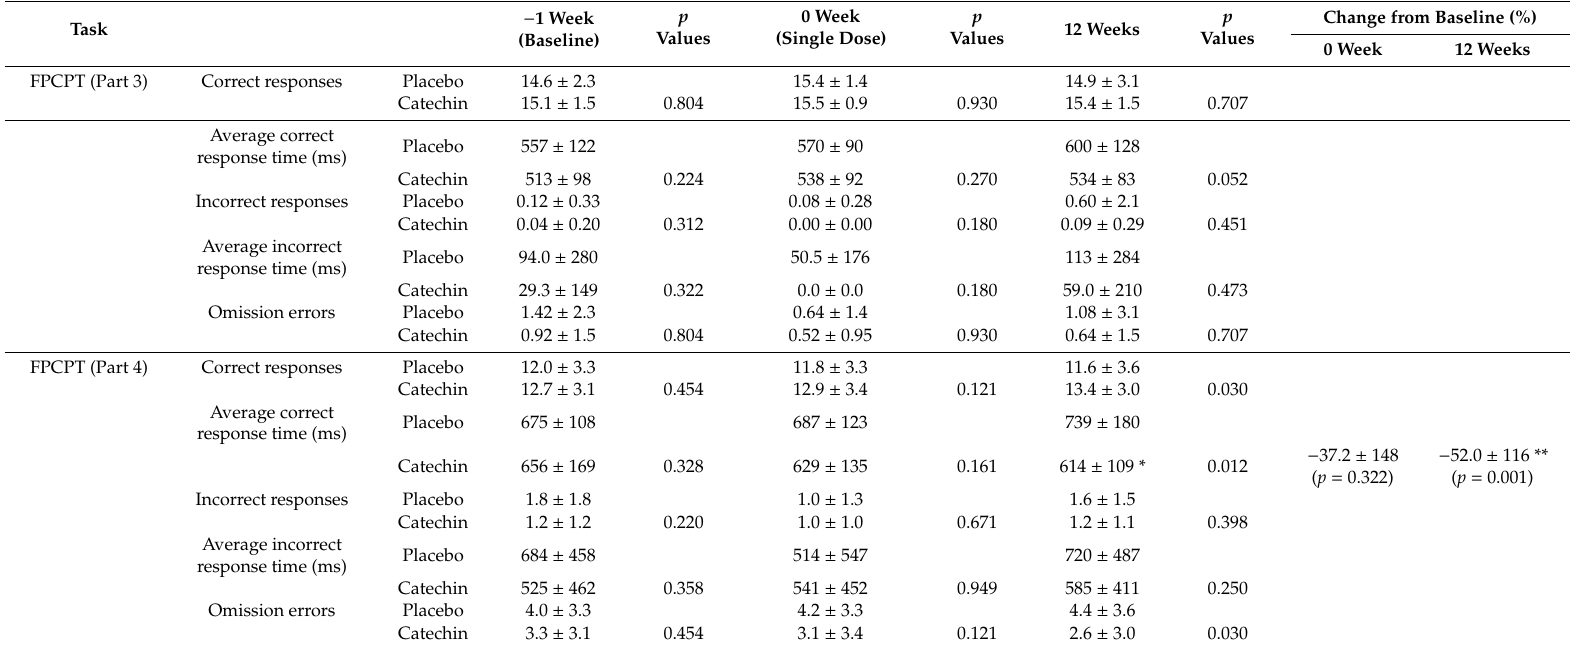
Table 5. E ff ects of green tea catechins on working memory-related